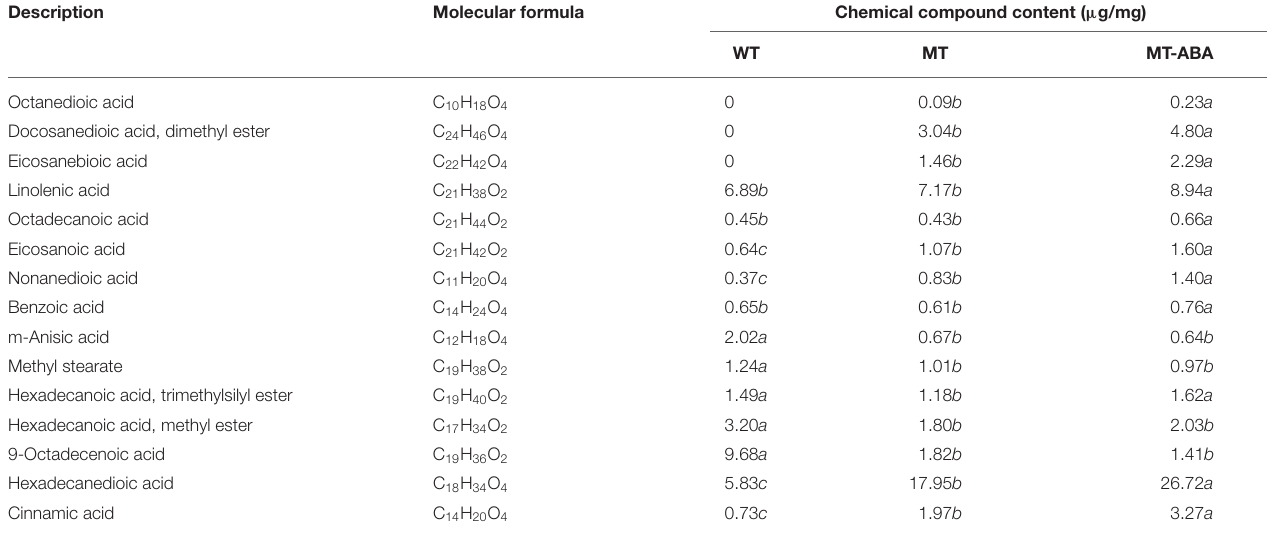
TABLE 1 | Chemical compound composition of the pear exocarp.